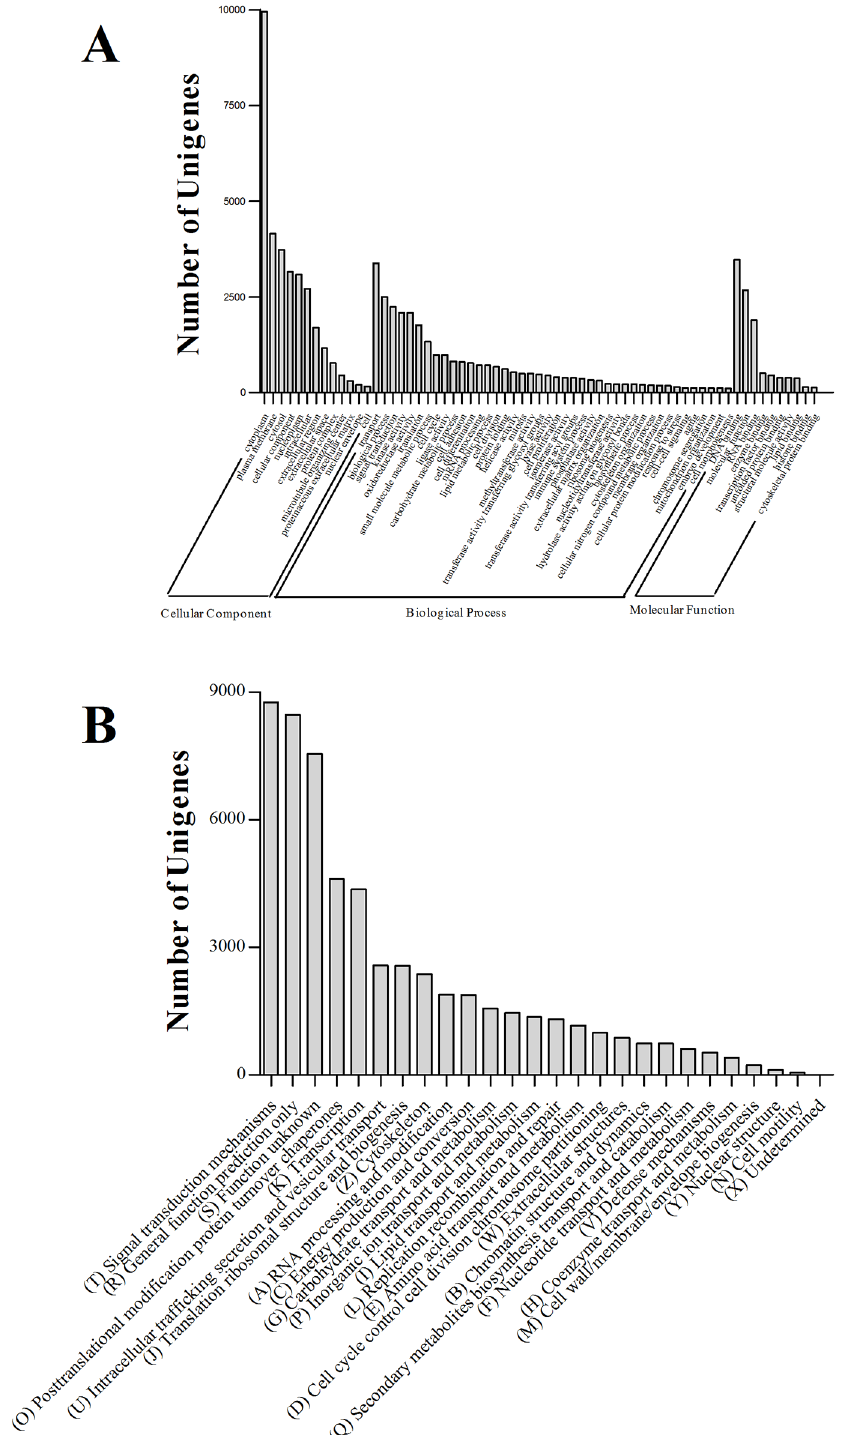
Fig 3. Functional annotation of C . idella Unigenes. (A) Go term distribution for the cellular component, biological process and molecular function categories. (B) eggNOG annotation.